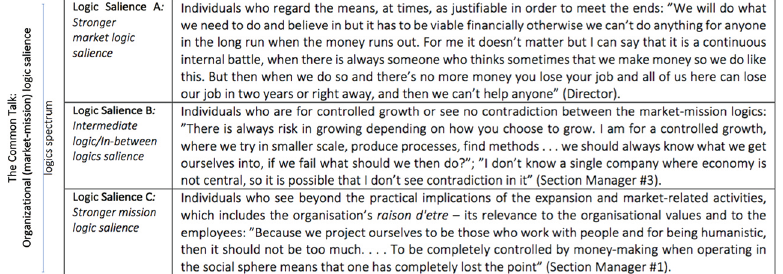
Figure 1: A selection of empirical excerpts that synthesize the different categories of individuals’ logic salience, along the same market-mission logics